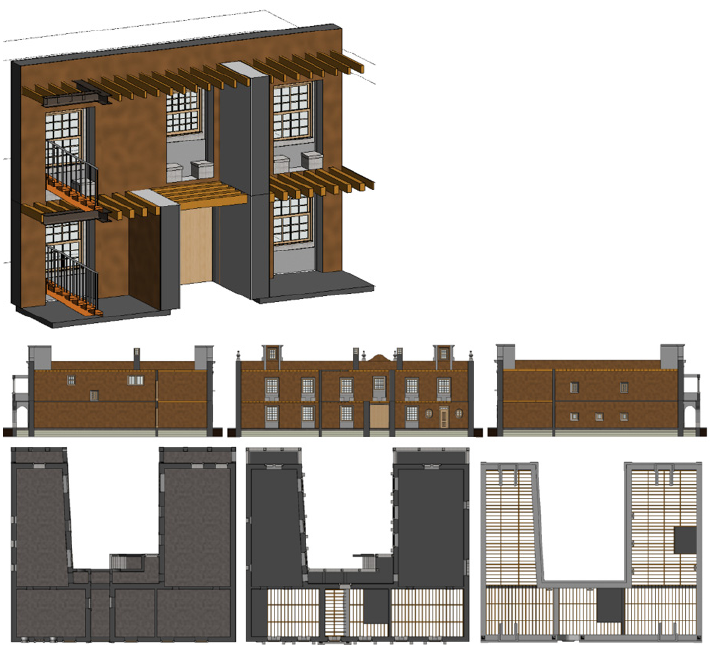
Figure 27. Interior detail of the model, elevations, and plants of all levels. Roof